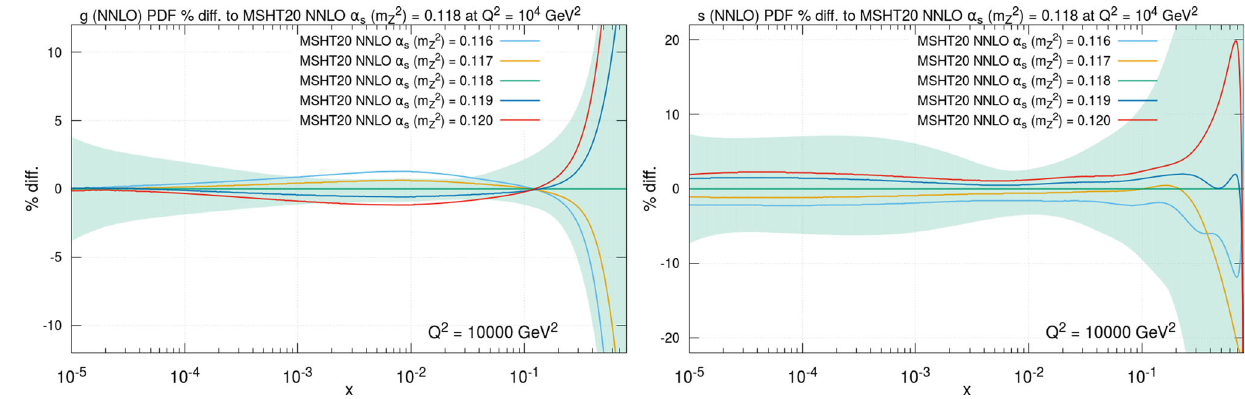
) = 0 . 118 ) set for fits Z